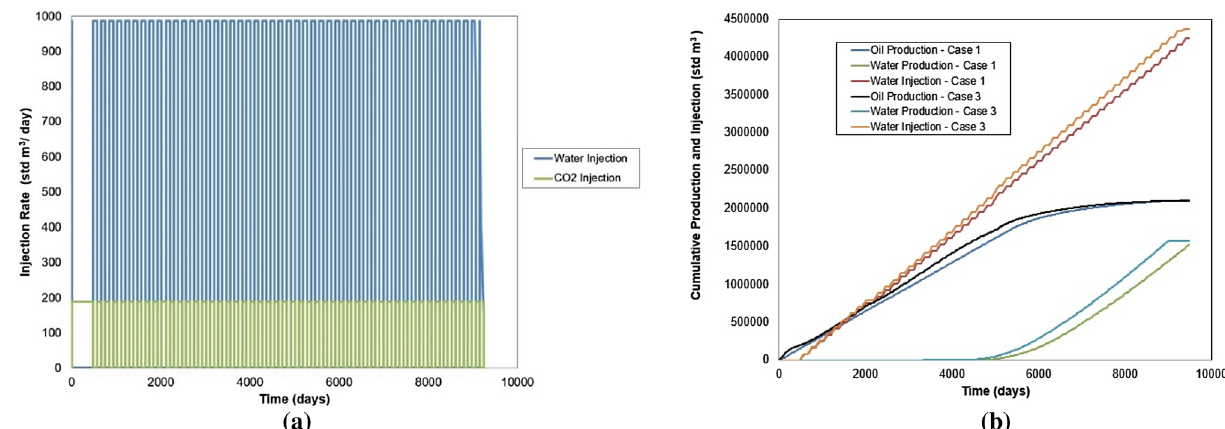
Fig. 6 Graphs of ( a ) water and CO 2 injection rate curves and ( b ) cumulative production and injection for WAG recovery in case 3 in comparison with the base case Table 12 Results of case 4 (with hysteresis and